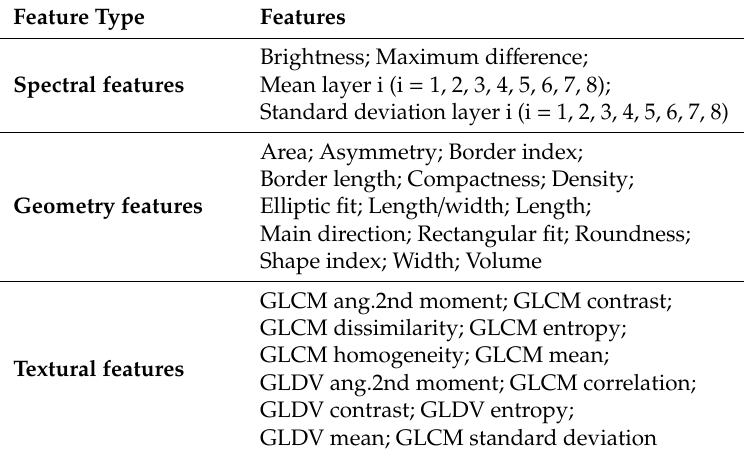
Table 1. Object features used for image analysis with the object-based SVM method. GLCM: gray-level co-occurrence matrix. GLDV: gray-level di ff erence